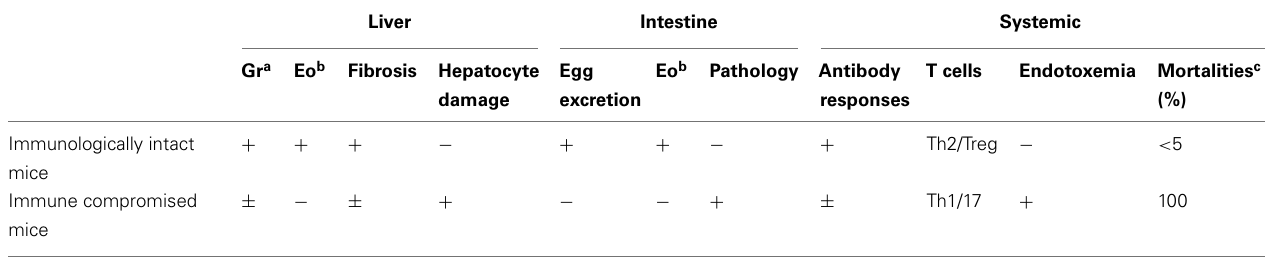
Table 1 | Summary of the consequence of S. mansoni egg infection in immunologically intact and immune compromised (e.g., CD4 + T cell depleted)